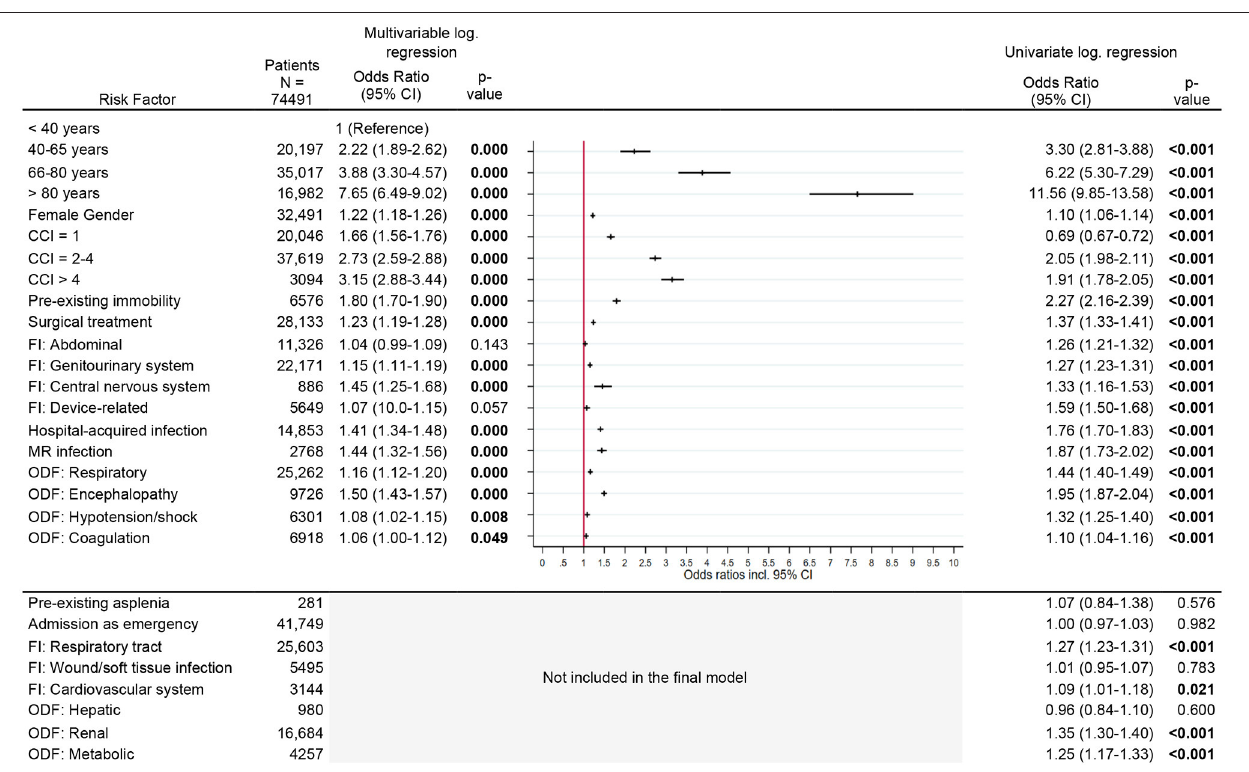
FIGURE 2 | Risk factors for new chronic care dependency. Legend: CCI, Charlson Comorbidity Index; FI, Focus of infection; MR, Multi-resistant; ODF, Organ